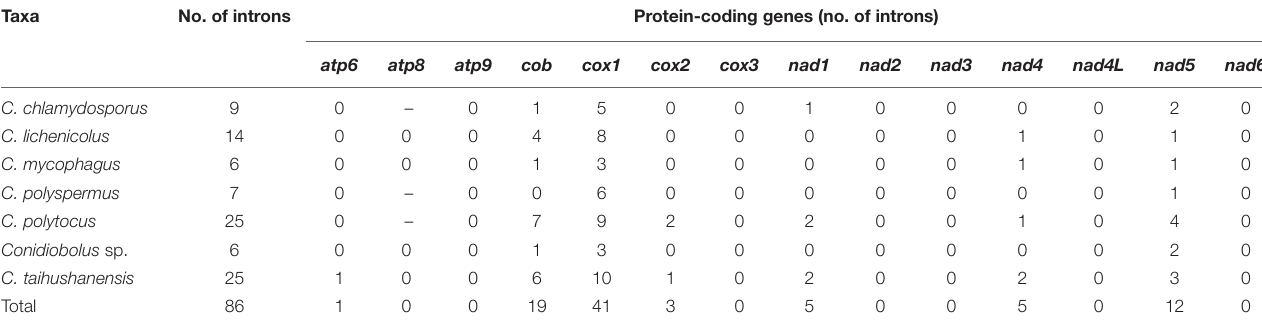
Conidiobolus sp.